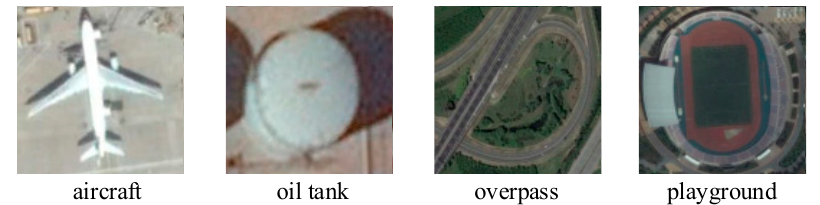
Figure 11. Each category of objects in RSOD.